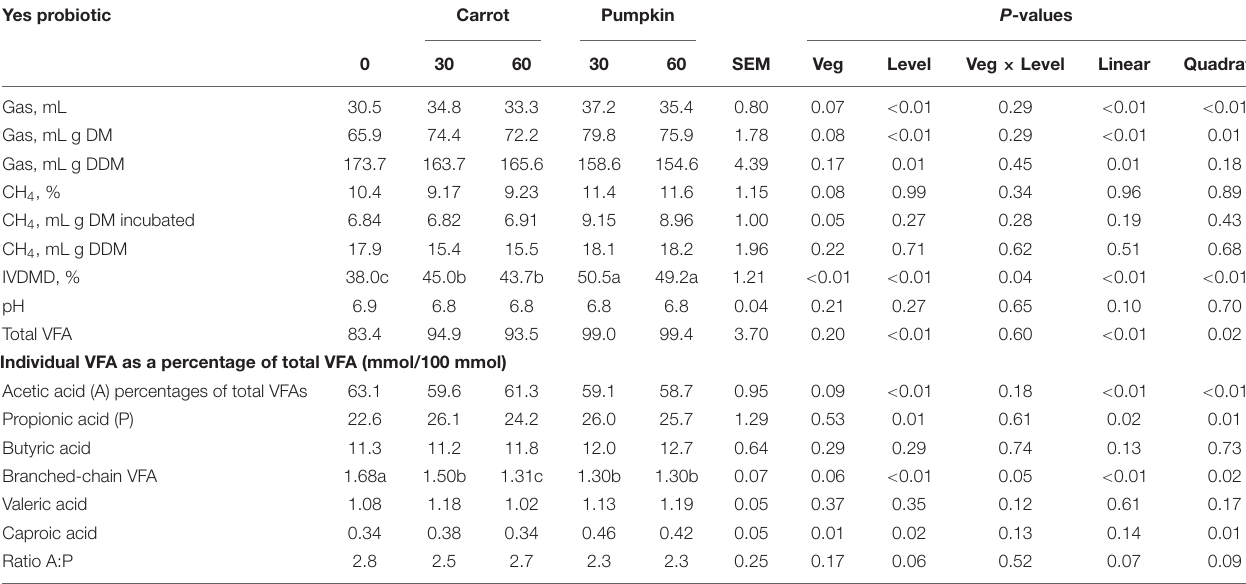
TABLE 6 | In vitro volatile fatty acid composition of sorghum silages ensiled with carrot or pumpkin at 0, 30, or 60% DM, with (yes) probiotics. Yes probiotic Carrot Pumpkin P